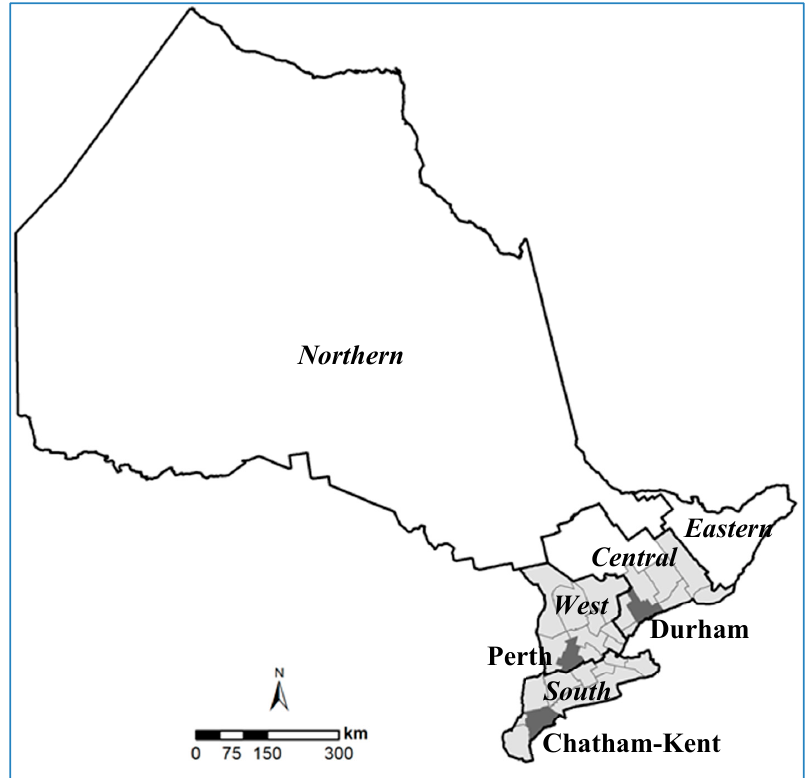
Figure 1. Study area in Ontario, Canada. The dark lines outline the five regions in Ontario; the light gray polygons are counties included in the study, and the dark gray polygons are three counties representative of Southern (Chatham-Kent), Western (Perth), and Central (Durham) Ontario.